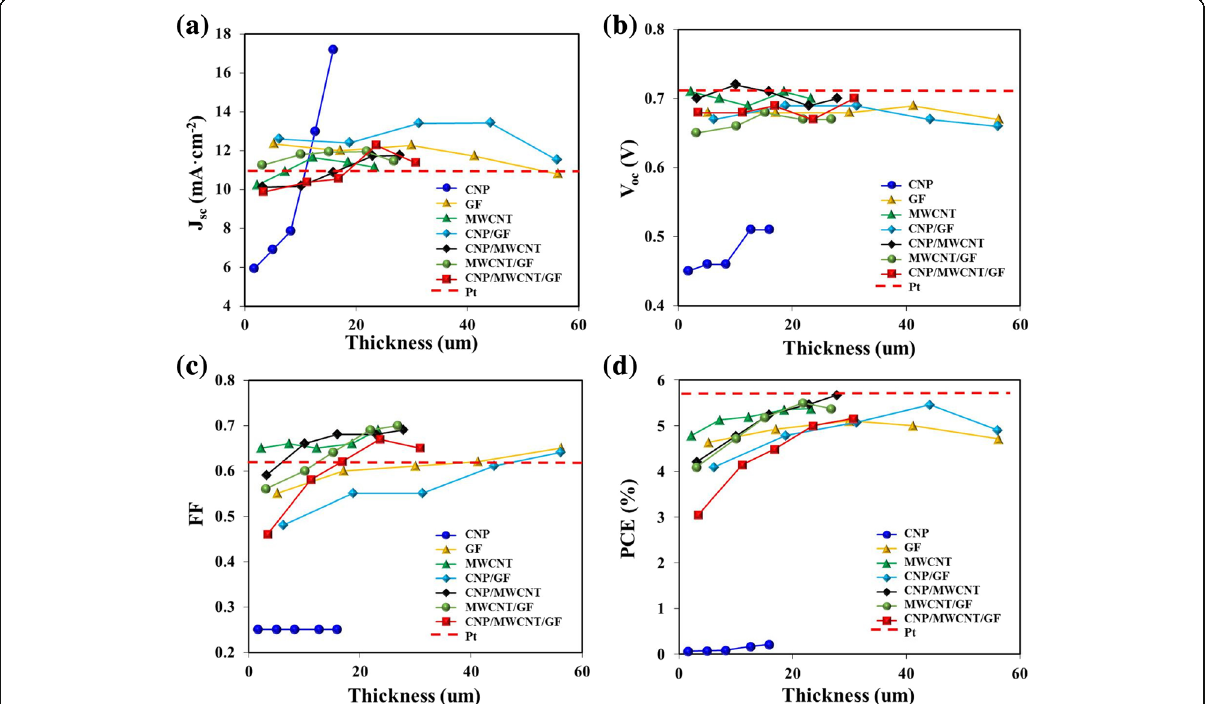
Fig. 6 The comparison of photovoltaic performances of DSSCs composed of various carbon materials- and Pt-based CEs in terms of a J sc , b V oc , c FF, and d